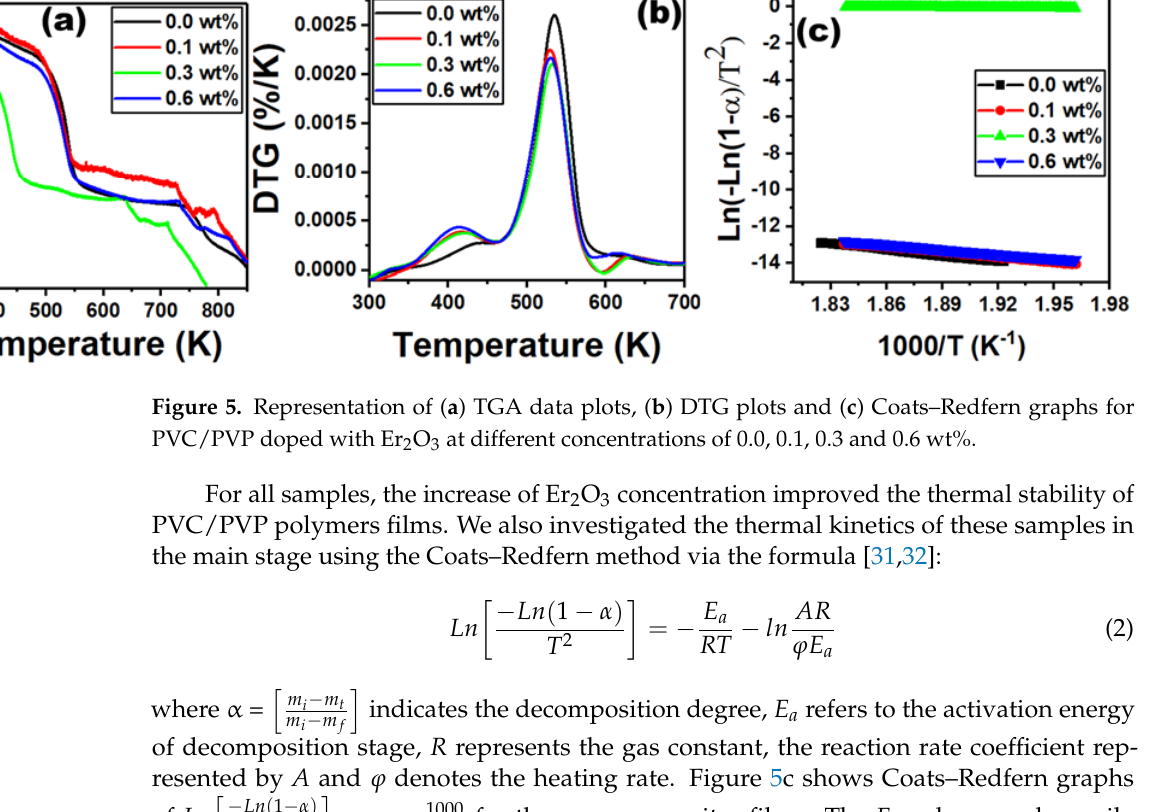
Figure 4. Raman spectra for blend nanocomposites PVC/PVP with different concentrations of Er 2 O 3.